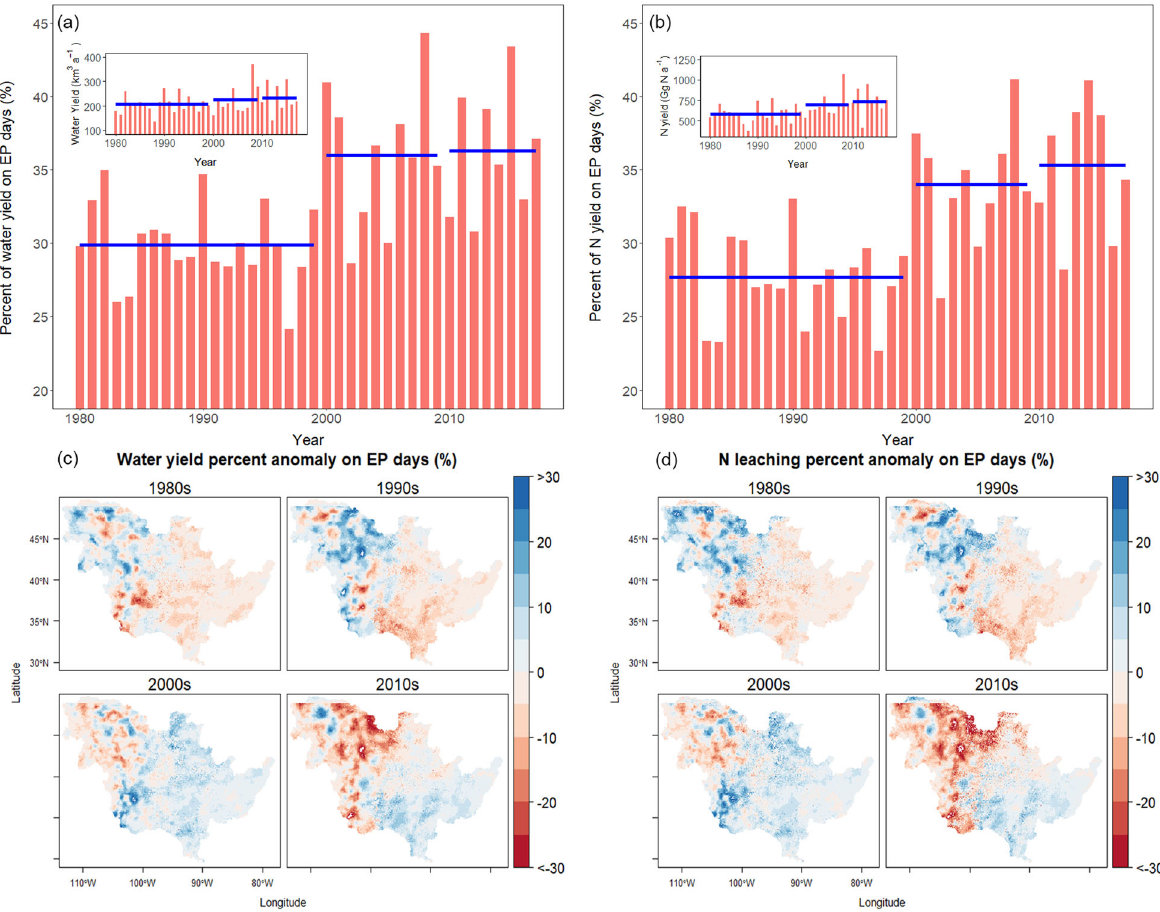
Fig. 5 The model-estimated water yield and N yield occurred in the days with extreme precipitation over the Basin during 1980 – 2017. The percentage of water yield ( a ) and N yield ( b ) occurred in the days with extreme precipitation (EP) relative to annual total in the Basin. The blue horizontal lines in a , b represent the average of 1980 – 1999, the 2000s, and 2010s, respectively. The inset fi gures are the annual accumulative water and N yield during extreme precipitation days, and the horizontal lines represent the average of each period. The spatial maps indicate anomaly of extreme precipitation contribution to annual water yield (surface and sub-surface runoff) ( c ) and N yield (refers to N leaching to local waters) ( d ) compared with long-term (1980 – 2017) average across the MARB in each